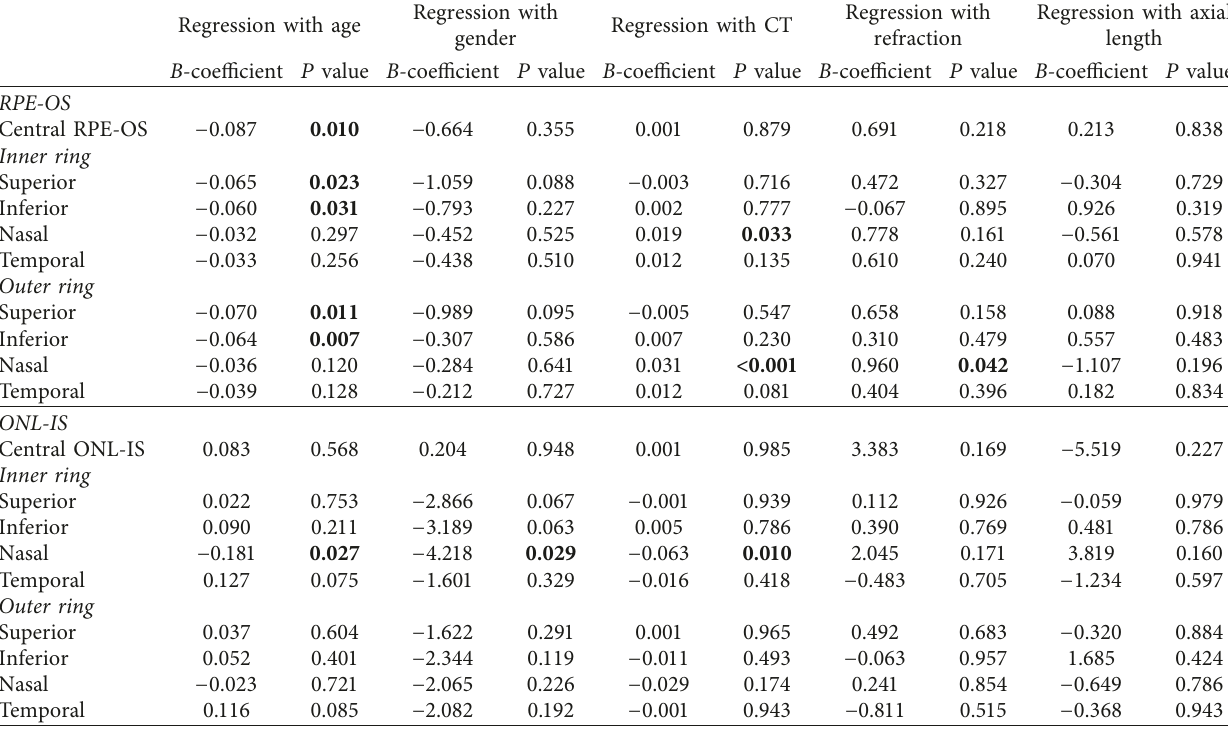
Table 4: Multiple regression analysis of different factors affecting the thickness of 9 ETDRS subfields of RPE-OS and ONL-IS. Regression with Regression with Regression with axial Regression with age Regression with CT gender refraction